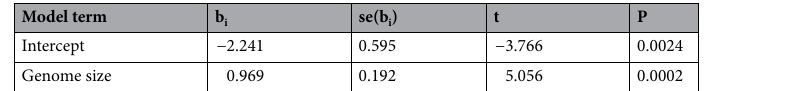
Table 2. Outcome of the regression model: Total centromere size based on ChIP-seq ~ Genome size. The outcome of the linear regression model of the relationship of Total centromere size (log-transformed)